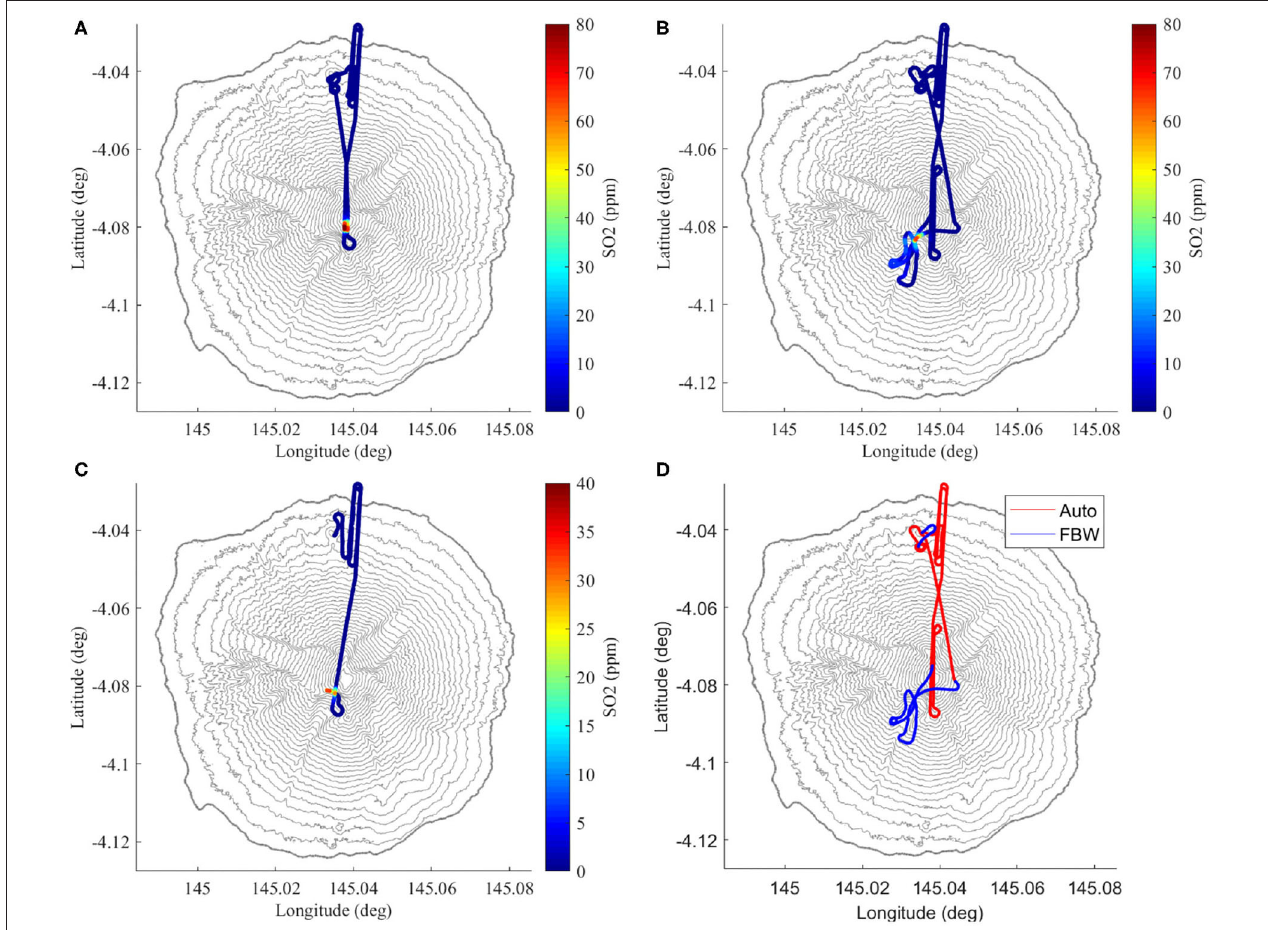
FIGURE 5 | (A–C) The three flight paths colored by SO 2 concentrations. Note how the highest SO 2 concentrations change location near the summit due to varying wind conditions. (D) The changing flight modes for flight B with AUTO (takeoff, ascent) and FBW (plume intercept, landing).